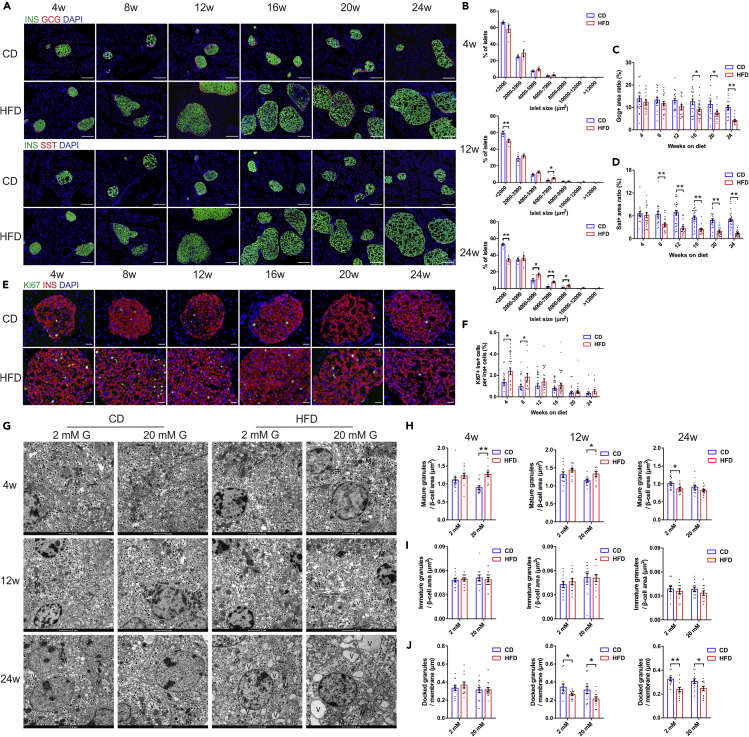
Dynamic changes in islet morphology, cell composition, and ultrastructure(A) Representative immunofluorescent images showing consecutive pancreatic sections double-labeled either for insulin and glucagon or insulin and somatostatin (scale bar: 50 μm).(B) Islet size distributions analyzed by morphometry (N = 5 mice/group).(C and D) Quantification of glucagon (C) and somatostatin (D) stained area (N = 15–25 islets/group, N = 4–5 mice/group).(E) Representative immunofluorescent images showing Ki67+ Ins+ cells in pancreatic sections (scale bar: 20 μm)(F) Quantification of the percentage of Ki67+ Ins+ cells in total Ins+ cells (N ≥ 14 islets/group, N = 3–5 mice/group).(G) Representative electron micrographs showing β-cells with insulin-containing granules after 2 mM or 20 mM glucose stimulation. Mitochondria (M), endoplasmic reticulum(RER), and vacuoles (V) are marked (scale bar: 2 μm).(H–J) Quantification of mature (H), immature (I), and docked (J) insulin granules in β-cells of HFD and CD islets (N = 12 β-cells/group, N = 6–8 islets/group, N = 3 mice/group).All data are expressed as mean ± SEM and analyzed using unpaired two-tailed t test. ∗p < 0.05, ∗∗p < 0.01. See also Figure S2.